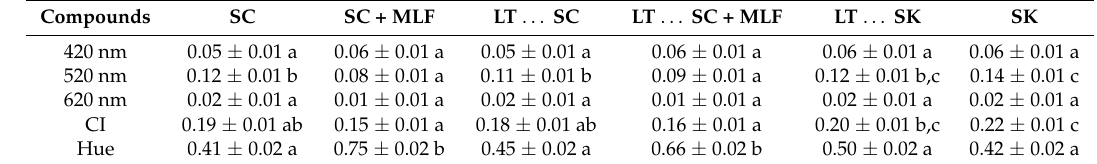
Results are the mean ± SD of three replicates. Means in the same row with the same letter are not significantly different ( p <